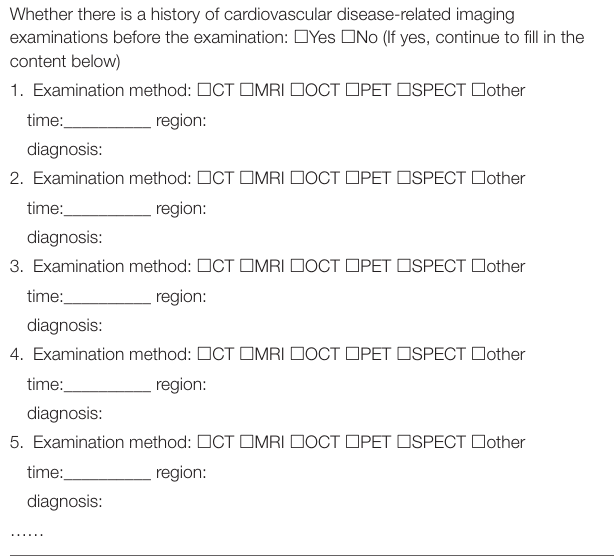
TABLE 5 | Baseline imaging tests